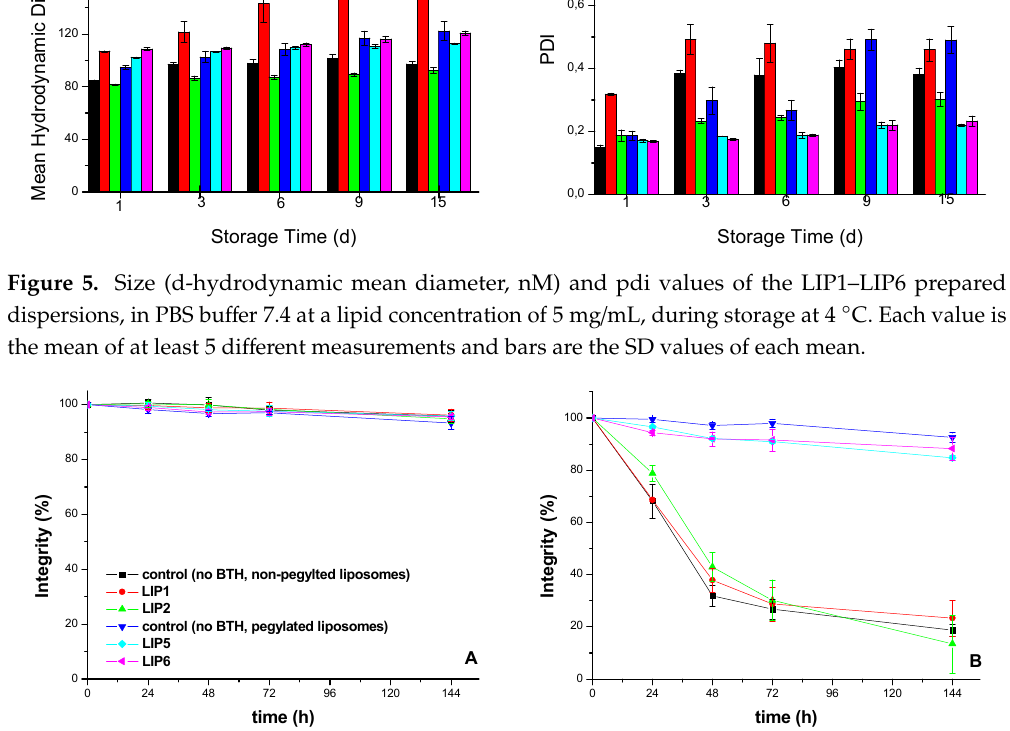
Figure 7. DSC thermographs of control nanoliposomes (no BTH) (a); LIP1 (10% BTH) (b); and LIP2 (20% BTH) (c). 3. Materials and Methods 3.1. Materials